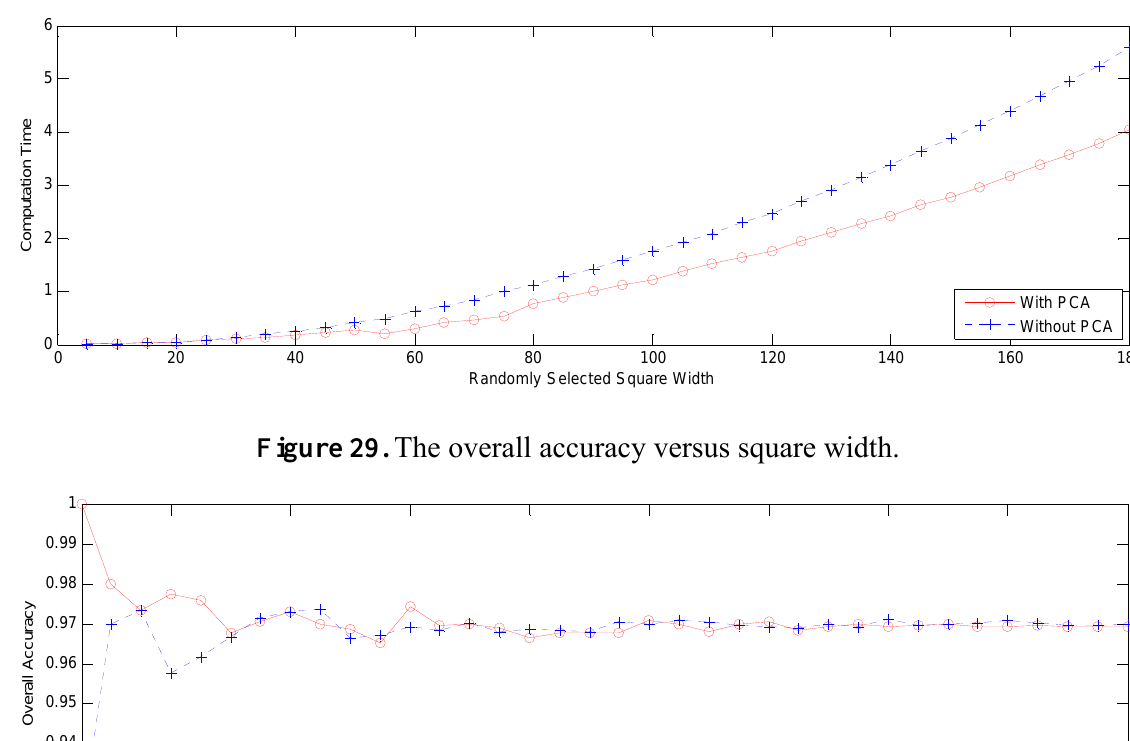
Figure 28. Computation time with square width.